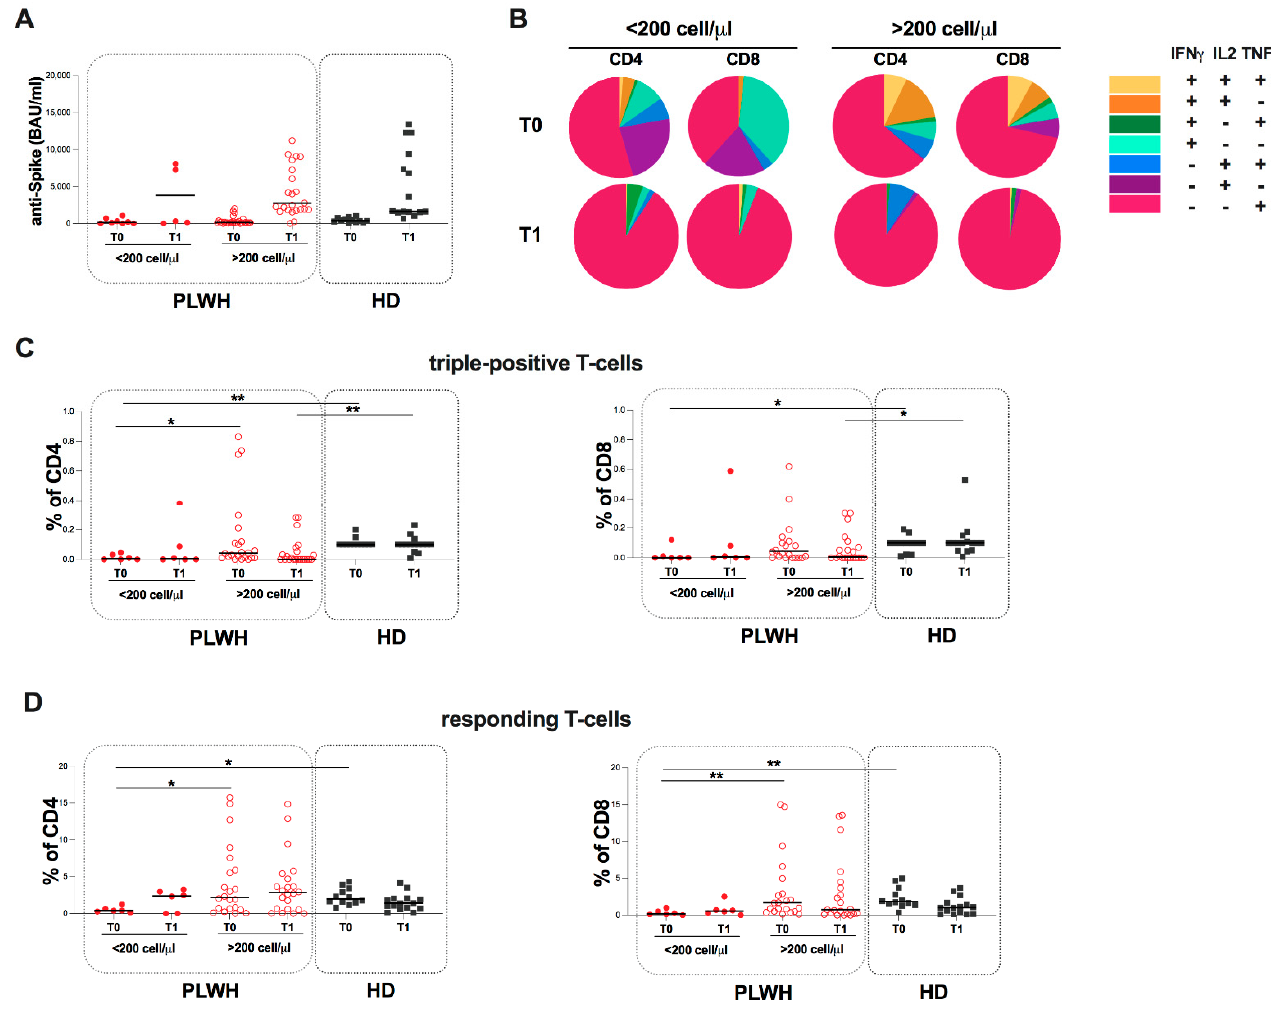
Figure 2. Evaluation of S-specific humoral and T-cell response in PLWH stratified according to CD4 cell count at T0 and T1. ( A ) Anti-S levels in PLWH stratified according to CD4 cell count. The differences between PLWH with <200 and PLWH with >200 subgroups were evaluated using the nonparametric Mann-Whitney test. Both CD4 > 200 and CD4 < 200 groups were compared to HD using the nonparametric Kruskal-Wallis test with Dunn’s post-test. Data are shown as median (lines). ( B ) Pie charts representing multifunctional cytokine analysis of specific CD4 and CD8 T-cells in PLWH stratified according to CD4 cell count. ( C ) Percentage of triple-positive T-cells in PLWH stratified according to CD4 cell count. The differences between CD4 > 200 and CD4 < 200 groups were evaluated using the nonparametric Mann-Whitney test. Both CD4 > 200 and CD4 < 200 groups were compared to HD using the nonparametric Kruskal-Wallis test with Dunn’s post-test. Data are shown as median (lines). ( D ) Percentage of responding T-cells in PLWH stratified according to CD4 cell count. The differences between CD4 > 200 and CD4 < 200 groups were evaluated using the nonparametric Mann-Whitney test. Both CD4 > 200 and CD4 < 200 groups were compared to HD using the nonparametric Kruskal-Wallis test with Dunn’s post-test. Data are shown as median (lines). Statistical significance (p) is reported in the graphics. ** p < 0.01; * p < 0.05. At T1, no statistically significant differences were found in the percentage of respond- ing T-cells between the stratified subgroups, as well as between the stratified subgroups and HD